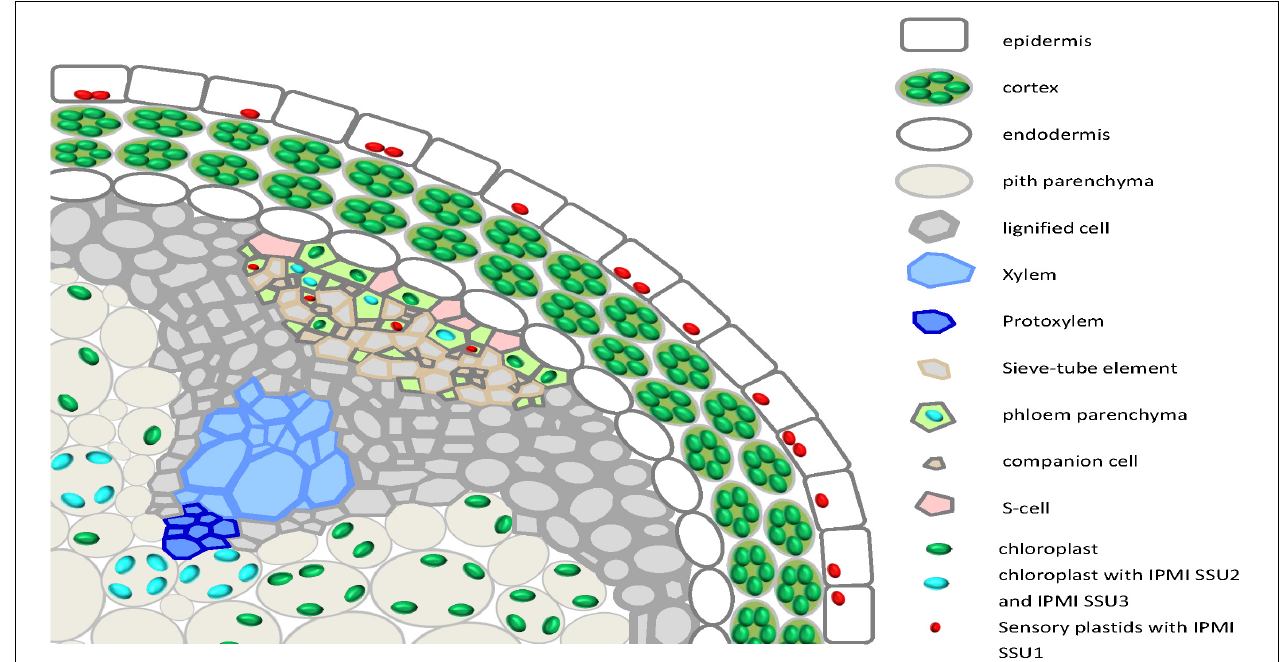
FIGURE 9 | A cartoon summarizing the expression of the different IPMI SSU proteins in a cross section through the flowering